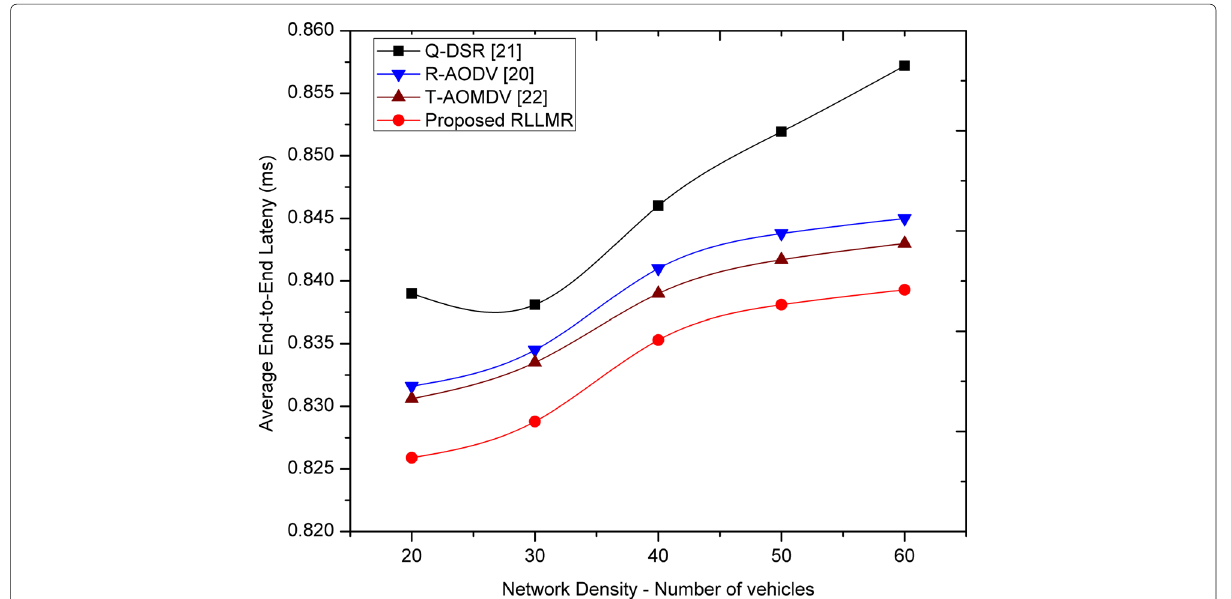
Fig. 10 Effect of different vehicles over end-to-end latency (Average speed 60 km/h, R 1000 m, t 10